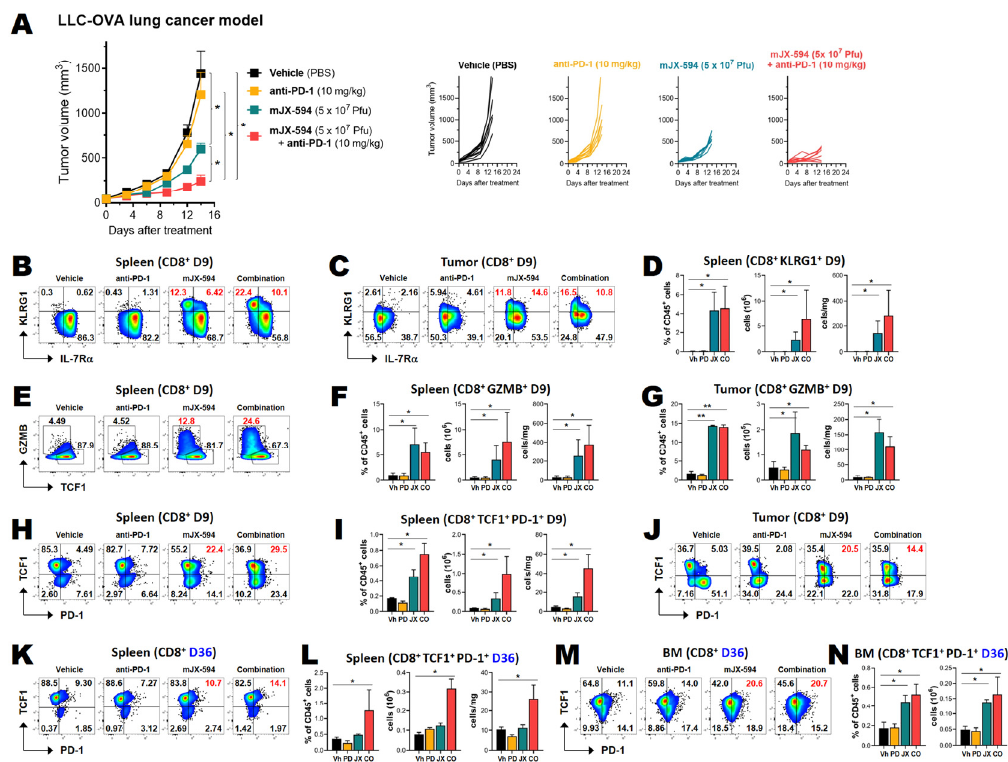
Figure 5. Tcf1 + stem-like CD8 + T cells including those directed against tumor-associated antigens, were increased by mJX-594 and further increased by anti-PD-1 antibody combination. LLC-OVA cancer cells were subcutaneously implanted into C57BL/6 mice. When tumors reached 50–60 mm 3 in volume, the mice were intratumorally injected with vehicle or 5 × 10 7 pfu of mJX-594 on days 0, 3, and 6. For combination therapy, anti-PD-1 antibody was intravenously injected five times at 3-day intervals, starting from the second treatment of mJX-594. Tumor growth was monitored until the end of the experiment (tumor volume ≤ 1500 mm 3 ). The tumor-infiltrating leukocytes and splenocytes were analyzed by flow cytometry at 9 days (D9), and splenocytes and bone marrow cells at 36 days (D36), after the first treatment with mJX-594. ( A ) Average tumor growth curve ( left ) and individual tumor growth curves ( right ) of LLC-OVA tumor-bearing mice after mJX-594 and anti-PD-1 combination treatment ( n = 7 per group). Group comparisons of tumor growth were carried out by two-way ANOVA with Bonferroni correction. Values are mean ± SEM. * p < 0.05. ( C ) Individual tumor growth curves of MC38 tumor-bearing mice after mJX-594 and anti-PD-1 combination treatment. ( n = 7 per group). ( B , C ) Relative proportions of memory precursor effector cells (IL-7R α + KLRG1 int ) and short-lived effector cells (IL-7R α − KLRG1 high ) among CD8 + T cells in spleen and tumor (D9). ( D ) Relative proportion among infiltrating leukocytes, the total cell numbers, and the number of cells per unit gram of tissue of KLRG1 + effector CD8 + T cells in spleen (D9). ( E ) Relative proportion of effector cells (TCF1 − GzmB + ) among CD8 + T cells in spleen (D9). ( F , G ) GzmB + effector CD8 + T cells in spleen and tumor (D9). ( H , I ) TCF1 + PD-1 + stem-like CD8 + T cells in spleen (D9). ( J ) TCF1 + PD-1 + stem-like CD8 + T cells in tumor (D9). ( K , L ) TCF1 + PD-1 + stem-like CD8 + T cells in spleen (D36). ( M , N ) TCF1 + PD-1 + stem-like CD8 + T cells in tumor (D36). Pooled data from two experiments are shown ( n = 6 per group). * p < 0.05, ** p < 0.005. CO, combination therapy; GZMB, granzyme B; LLC-OVA, LLC expressing OVA; JX, mJX-594; OVA, ovalbumin; PD, anti-PD-1; pfu, plaque-forming units; Vh,